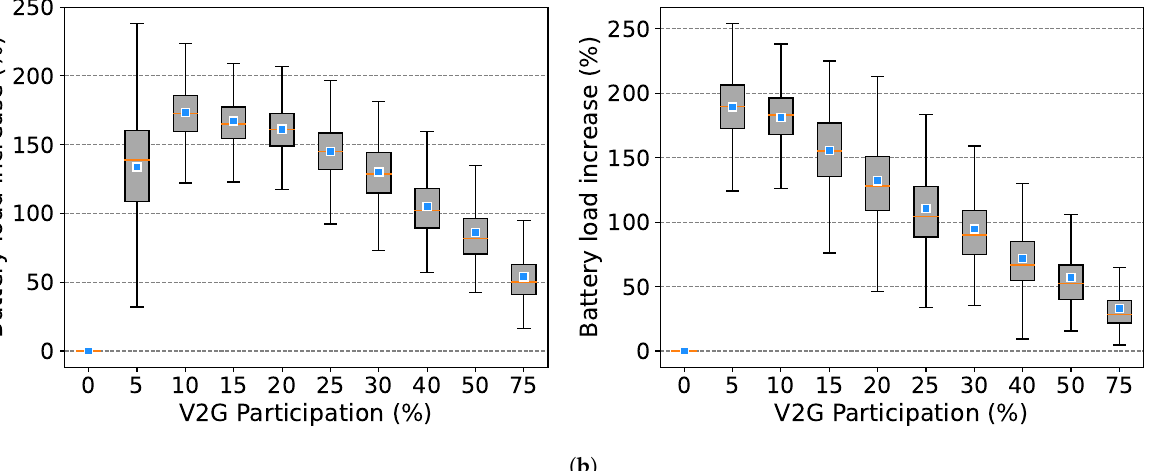
Figure 12. Battery load increase in the Berlin LORs due to V2G application. ( a ) Summer case. ( b ) Winter